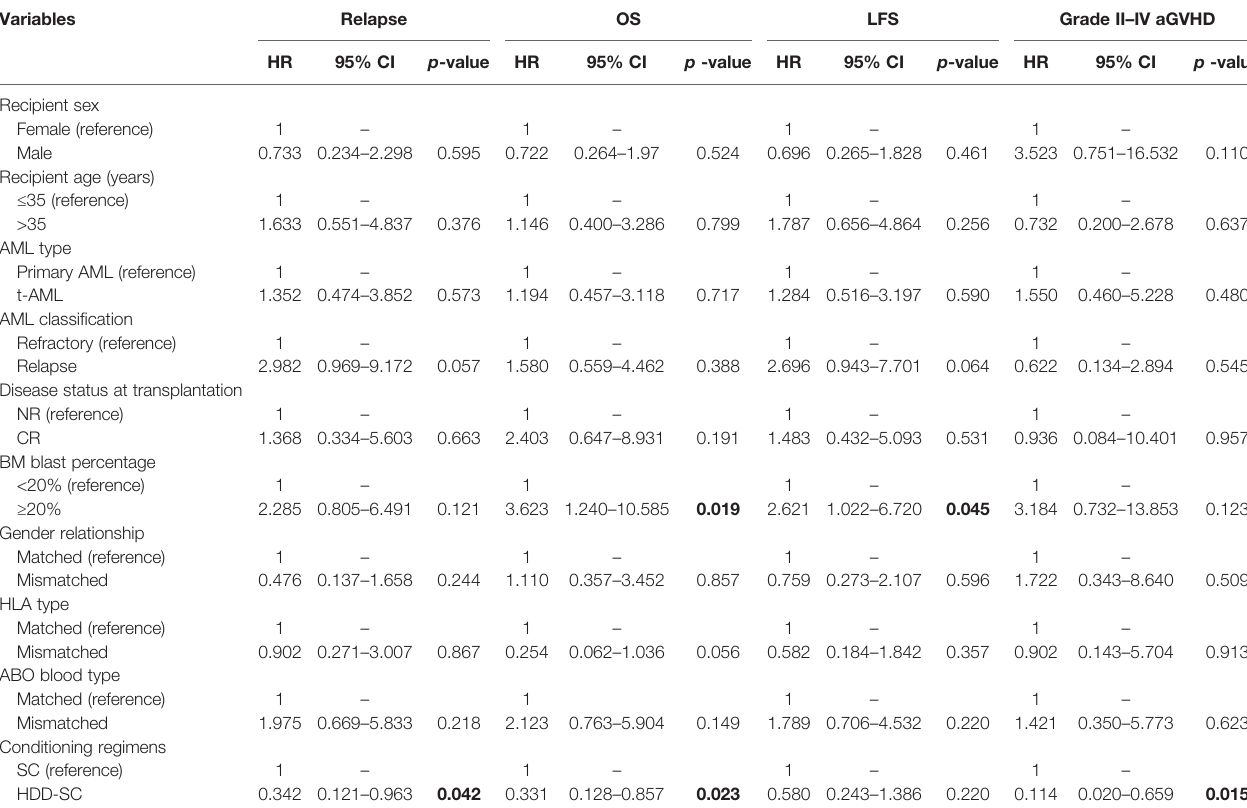
TABLE 3 | Multivariate analysis of relapse, OS, LFS, and grade II – IV aGVHD between the HDD-SC group and the SC